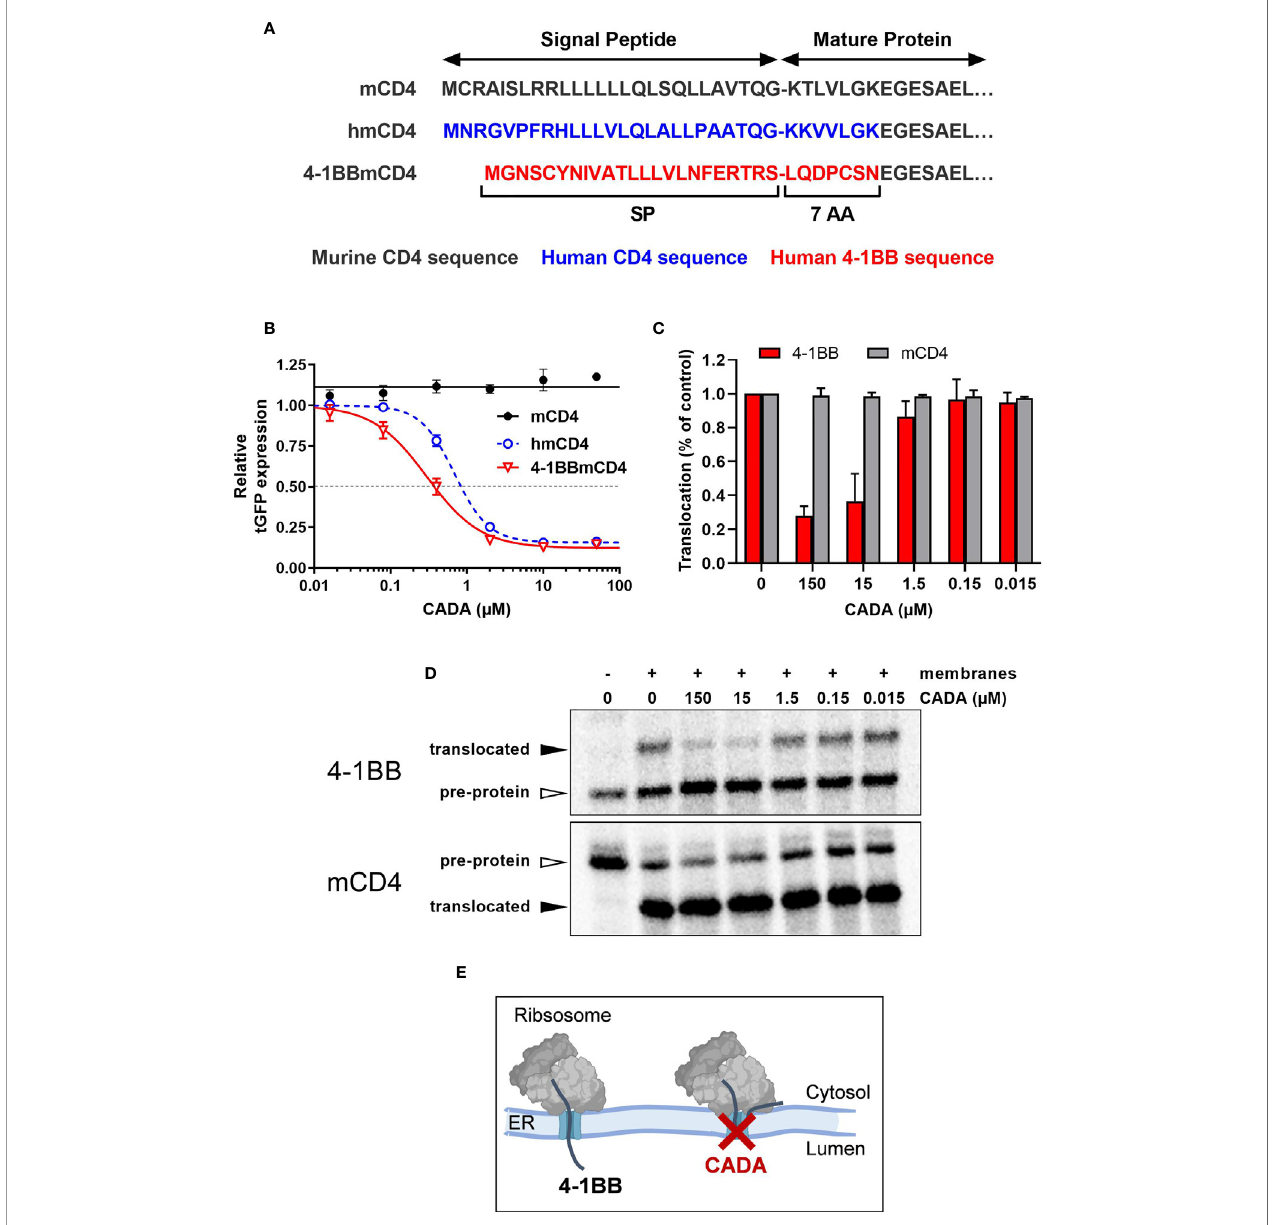
FIGURE 8 | CADA inhibits 4 ‑ 1BB protein biogenesis in a signal peptide-dependent way by blocking the co-translational translocation of 4 ‑ 1BB into the endoplasmic reticulum. (A) Schematic representation of the constructs used. In the hmCD4 construct, the signal peptide (SP) and the fi rst 7 amino acids of the mature protein are of human CD4 (indicated in blue), whereas in the 4-1BBmCD4 construct the SP and the 7 AA of mature 4-1BB (indicated in red) are fused to mouse CD4. During pre-protein biogenesis, the SP is cleaved off from the mature protein. The constructs express the mature protein of mouse CD4 that is C-terminally fused to tGFP as shown in Figure 7A . (B) HEK293T cells were transfected with the mCD4 (black; n=3), hmCD4 (blue; n=3) and 4 ‑ 1BBmCD4 (red; n=4) constructs. CADA was added 6h post transfection and expression of tGFP was measured by fl ow cytometry 24h post transfection. The tGFP expression is given as percentage of DMSO control (mean ± SD). IC 50 values are 0.84 m M, 0.38 µM and >50 m M for hmCD4, 4 ‑ 1BBmCD4 and mCD4, respectively. (C, D) In vitro translation and translocation of 4 ‑ 1BB and mCD4 in a radiolabeled cell-free rabbit reticulocyte lysate system. (C) Graph shows the calculated translocation ef fi ciencies. Signal intensities of the pre-protein and translocated protein fraction were used to calculate the translocation ef fi ciency, i.e., translocated fraction/(pre-protein + translocated fraction). Bars show mean ± SD; n=2. (D) Representative autoradiogram of the in vitro translated and translocated wild-type 4 ‑ 1BB and mCD4 proteins. For mCD4 a truncated form of 250 residues was used without glycosylation sites and transmembrane region. In the presence of membranes, the pre-protein (open arrowhead) of mCD4 is translocated into the ER lumen and the SP is cleaved off, resulting in a faster migrating mature protein (black arrowhead). For wild-type 4 ‑ 1BB, the SP is cleaved off but the protein is also glycosylated, resulting in a slower migrating mature protein (black arrowhead). (E) Cartoon showing CADA inhibiting the co-translational translocation of 4-1BB protein across the ER membrane. See also Supplementary Figure 8